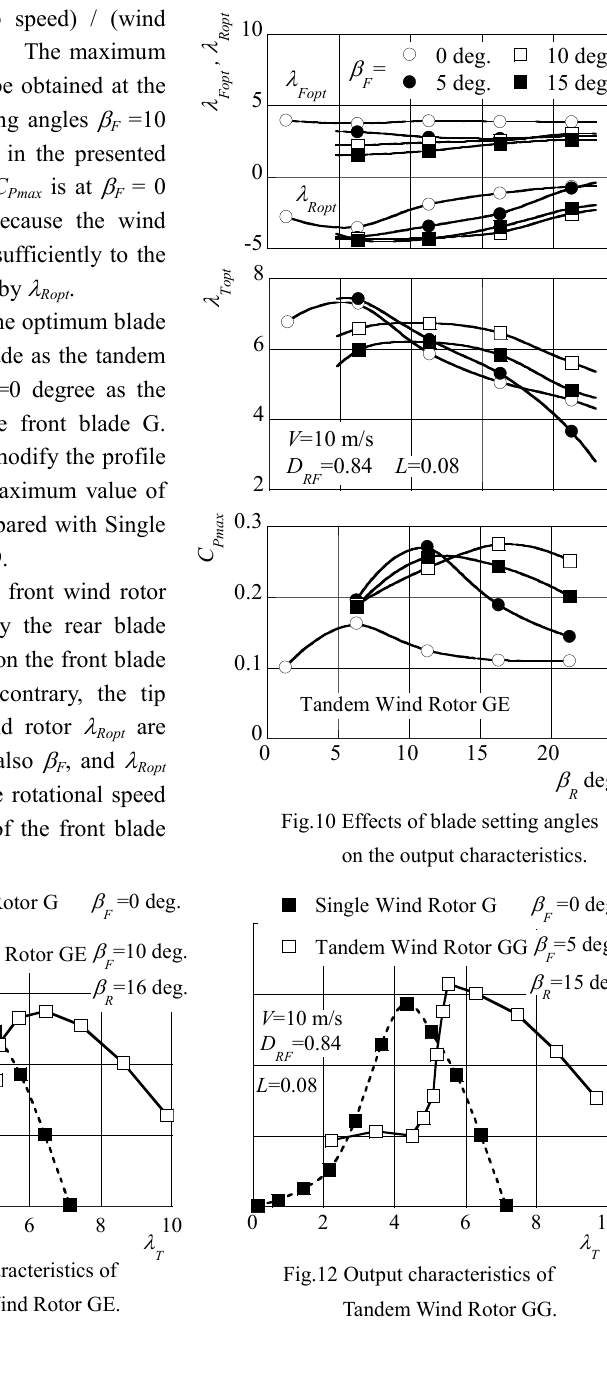
Fig.12 Output characteristics of Tandem Wind Rotor